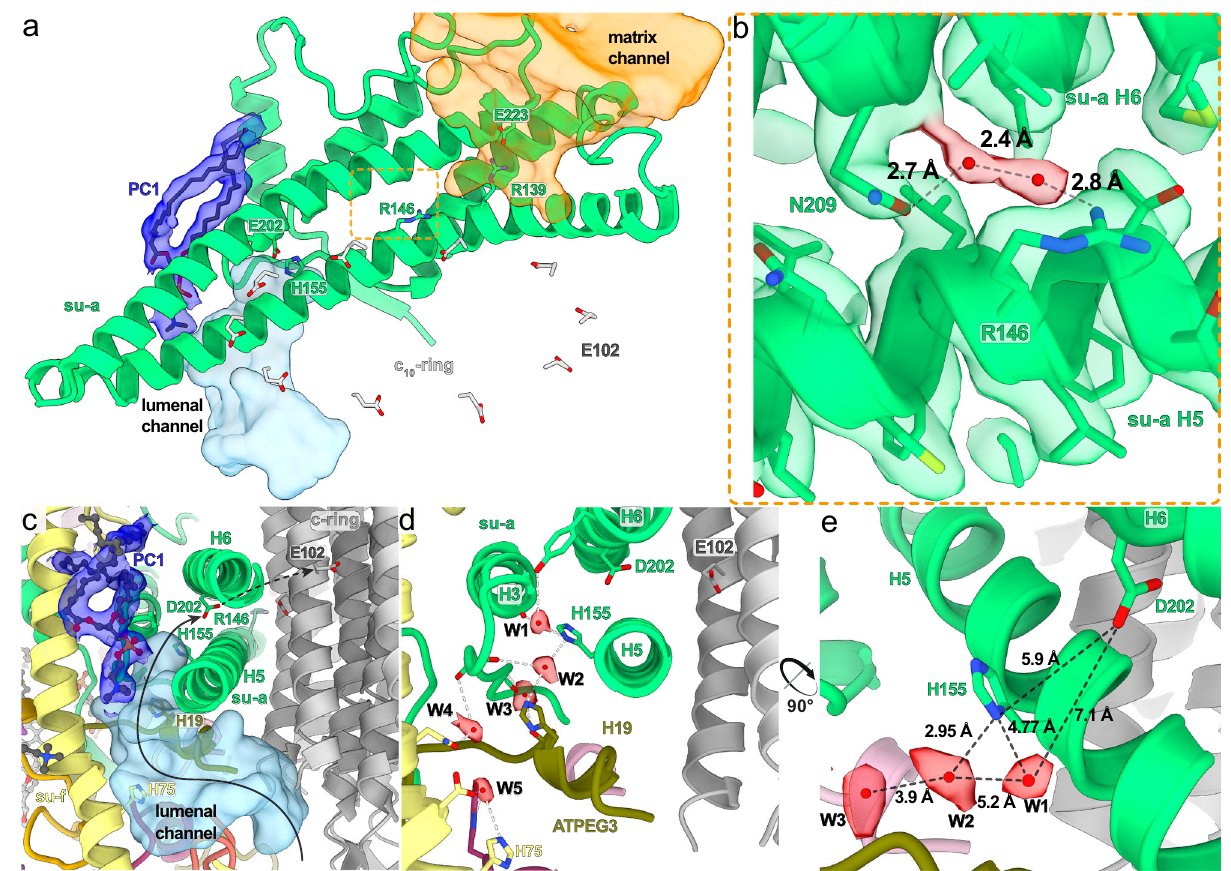
Fig. 4 | The lumenal half-channel contains ordered water molecules and is con fi ned by an F o -bound lipid. a Subunit- a (green) with the matrix (orange) and lumenal(lightblue)channels,andanorderedphosphatidylcholine(PC1;blue).E102 of the c 10 -ring shown in grey. b Close-up view of the highly conserved R146 a and N209 a ,whichcoordinatetwowatermoleculesbetweenhelicesH5-6 a . c Sideviewof